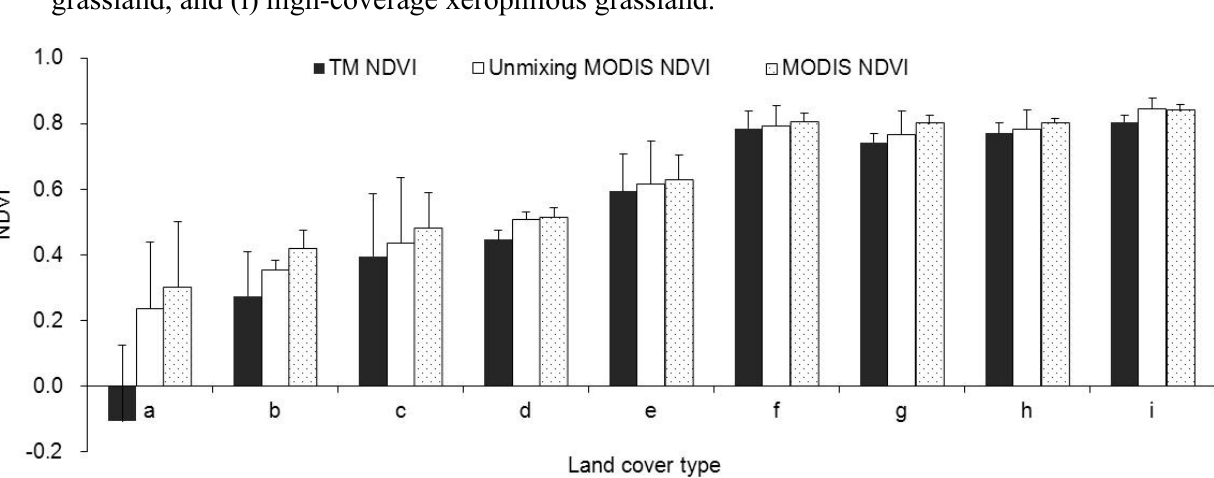
Figure 5. The comparison between the mean NDVI of TM, MODIS, and the unmixing result in 28 July 2009 for different land covers, including (a) open water, (b) urban or built-up land, (c) barren land, (d) peat land, (e) helobious grassland, (f) hygrophilous grassland, (g) low-coverage xerophilous grassland, (h) middle-coverage xerophilous grassland, and (i) high-coverage xerophilous